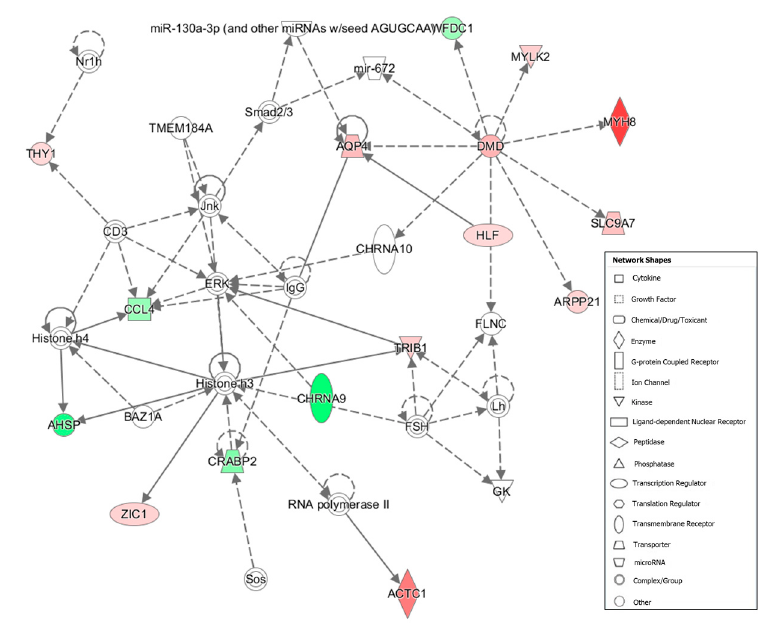
Figure 2. Gene network #6: Cell Morphology, Cellular Assembly and Organization, Cellular Function and Maintenance. Genes up-regulated and down-regulated in the Tender group are represented in green and red colors,